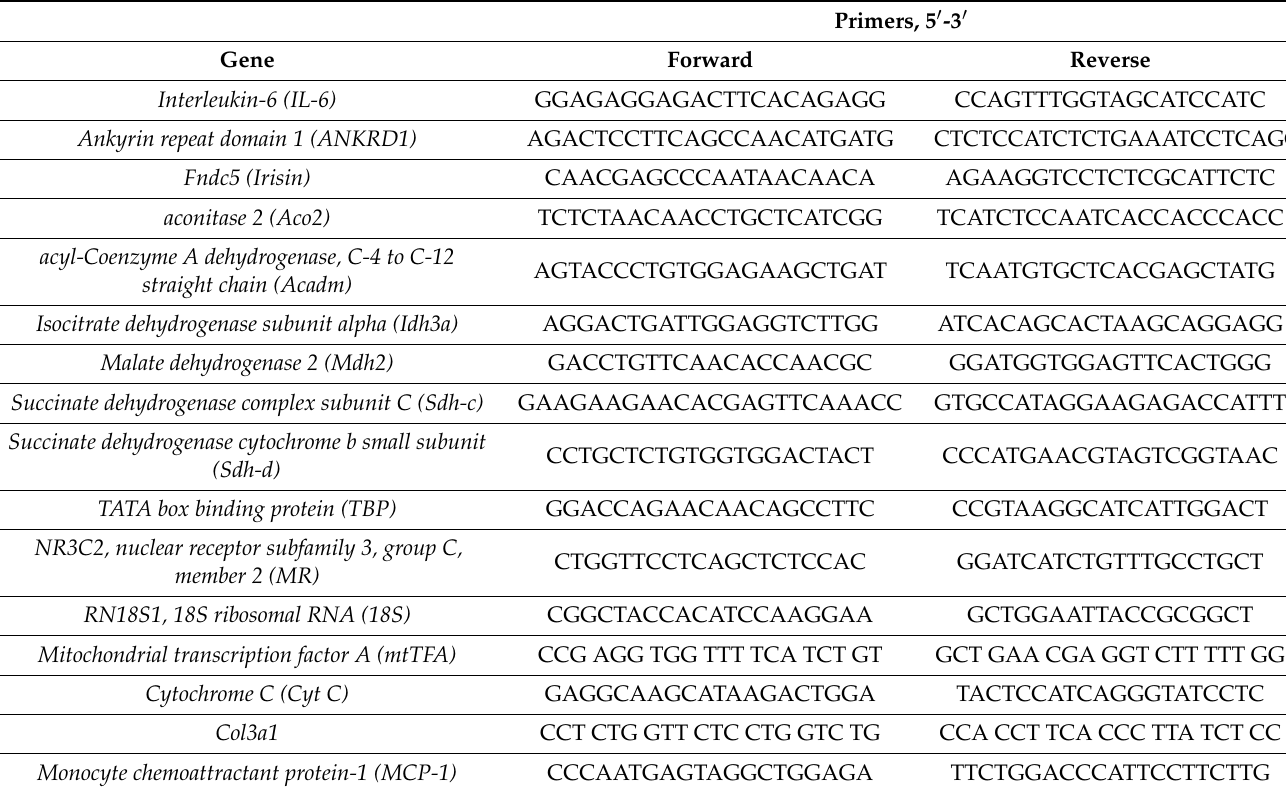
Table 1. Sequences of primers used in